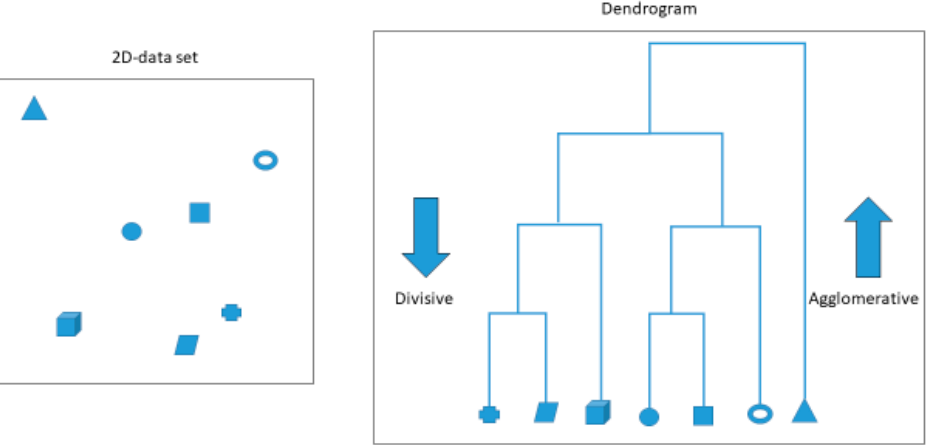
Figure 1. The final solution of the hierarchical clustering method showing a 2D dataset and corre- sponding dendrogram.